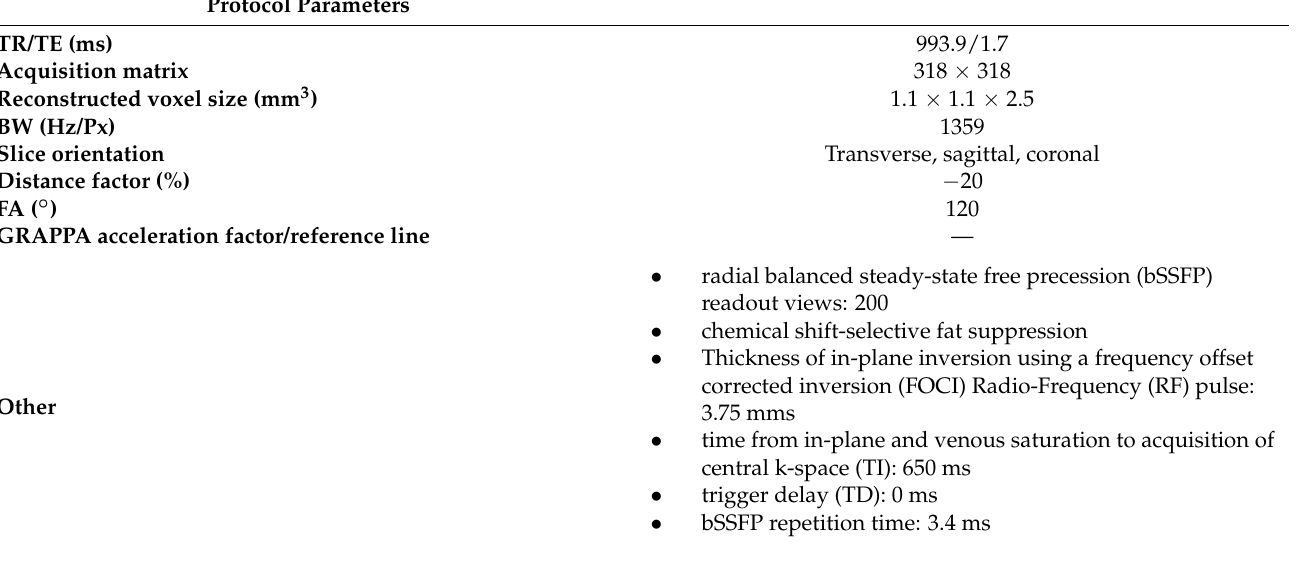
Table 1. MR protocol parameters used in this study. The repetition time is abbreviated to TR, echo time to TE, band width to BW, flip angle to FA, and generalized auto calibrating partially parallel acquisition to